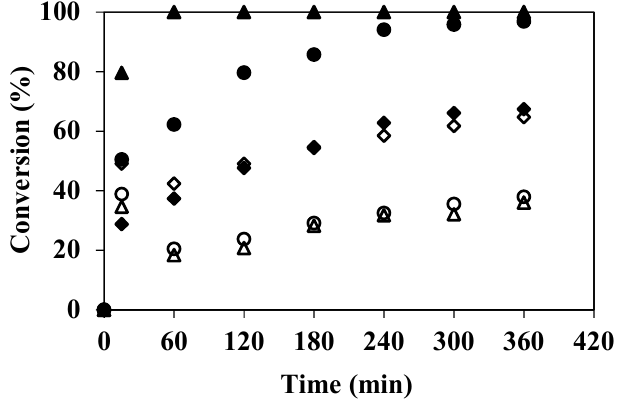
Figure 2. Conversion of 4-chlorophenol ( ◊ , ♦ ), guaiacol ( ○ , ● ), 2,6-dimetoxyphenol ( ∆ , ▲ ) degradation in EMR working in batch mode (without enzyme-open symbols-and with enzyme-closed symbols-, 100 mg·L − 1 of phenolic substrate in 50 mM citrate-phosphate buffer pH 4 with 0.1 mM of CuSO 4 , Δ P = 200 kPa, tangential velocity = 0.16 m·s − 1 , T = 40 °C, membrane pore diameter 0.2 μ m). The error of measurements is ≤